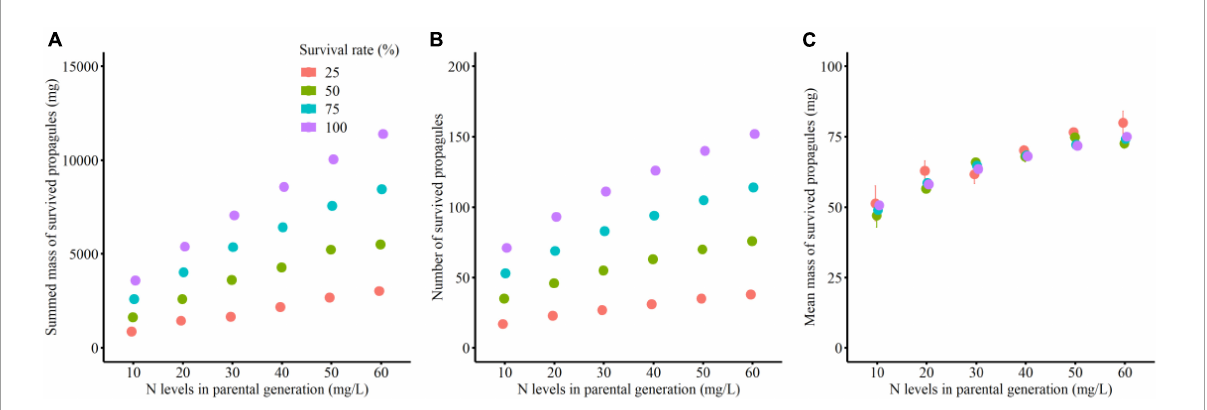
FIGURE2 Summed mass (A) , mean mass (B) and number (C) of the surviving clonal propagules produced by each parental plant in the simulation experiment.